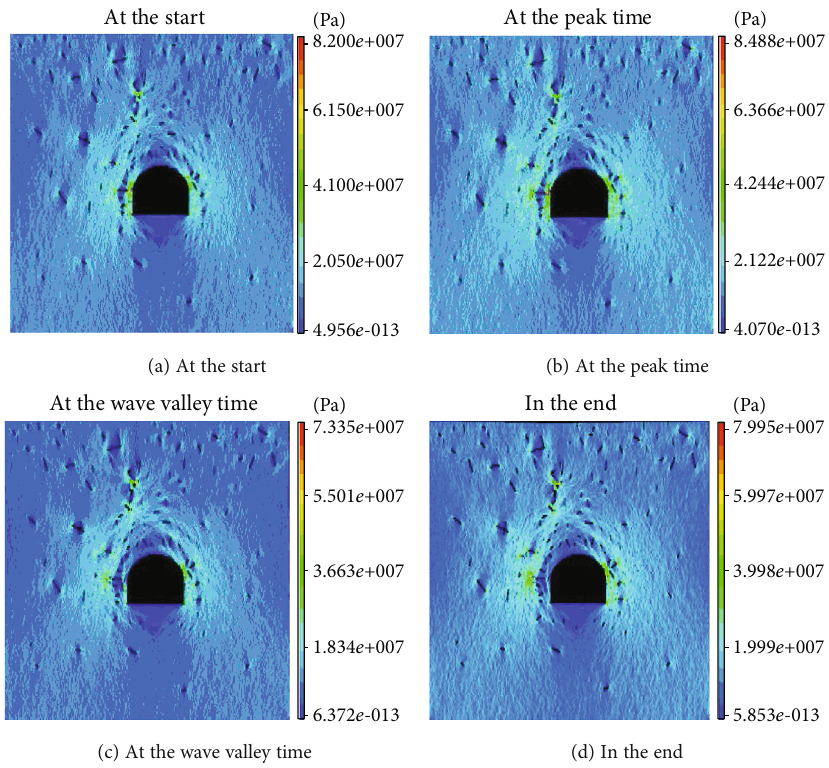
Figure 11: Shear stress evolution process in the fi rst cycle.